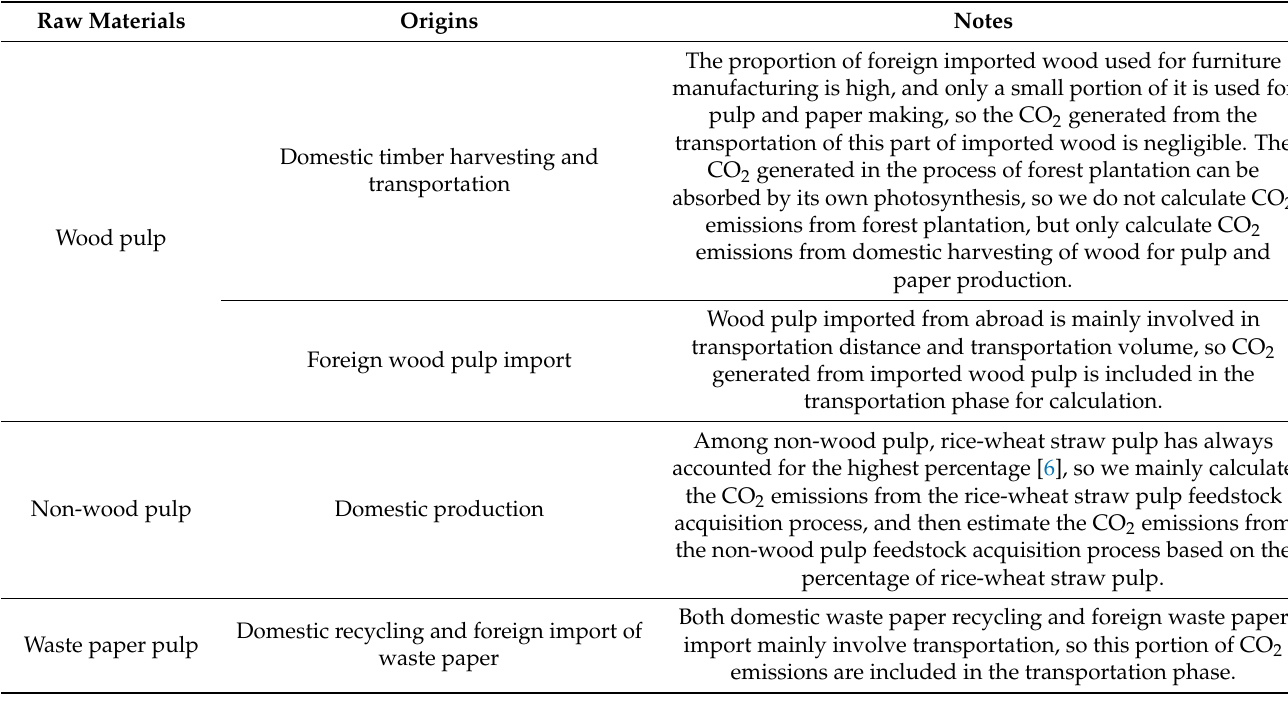
Table 1. Three sources of raw materials and definition of CO 2